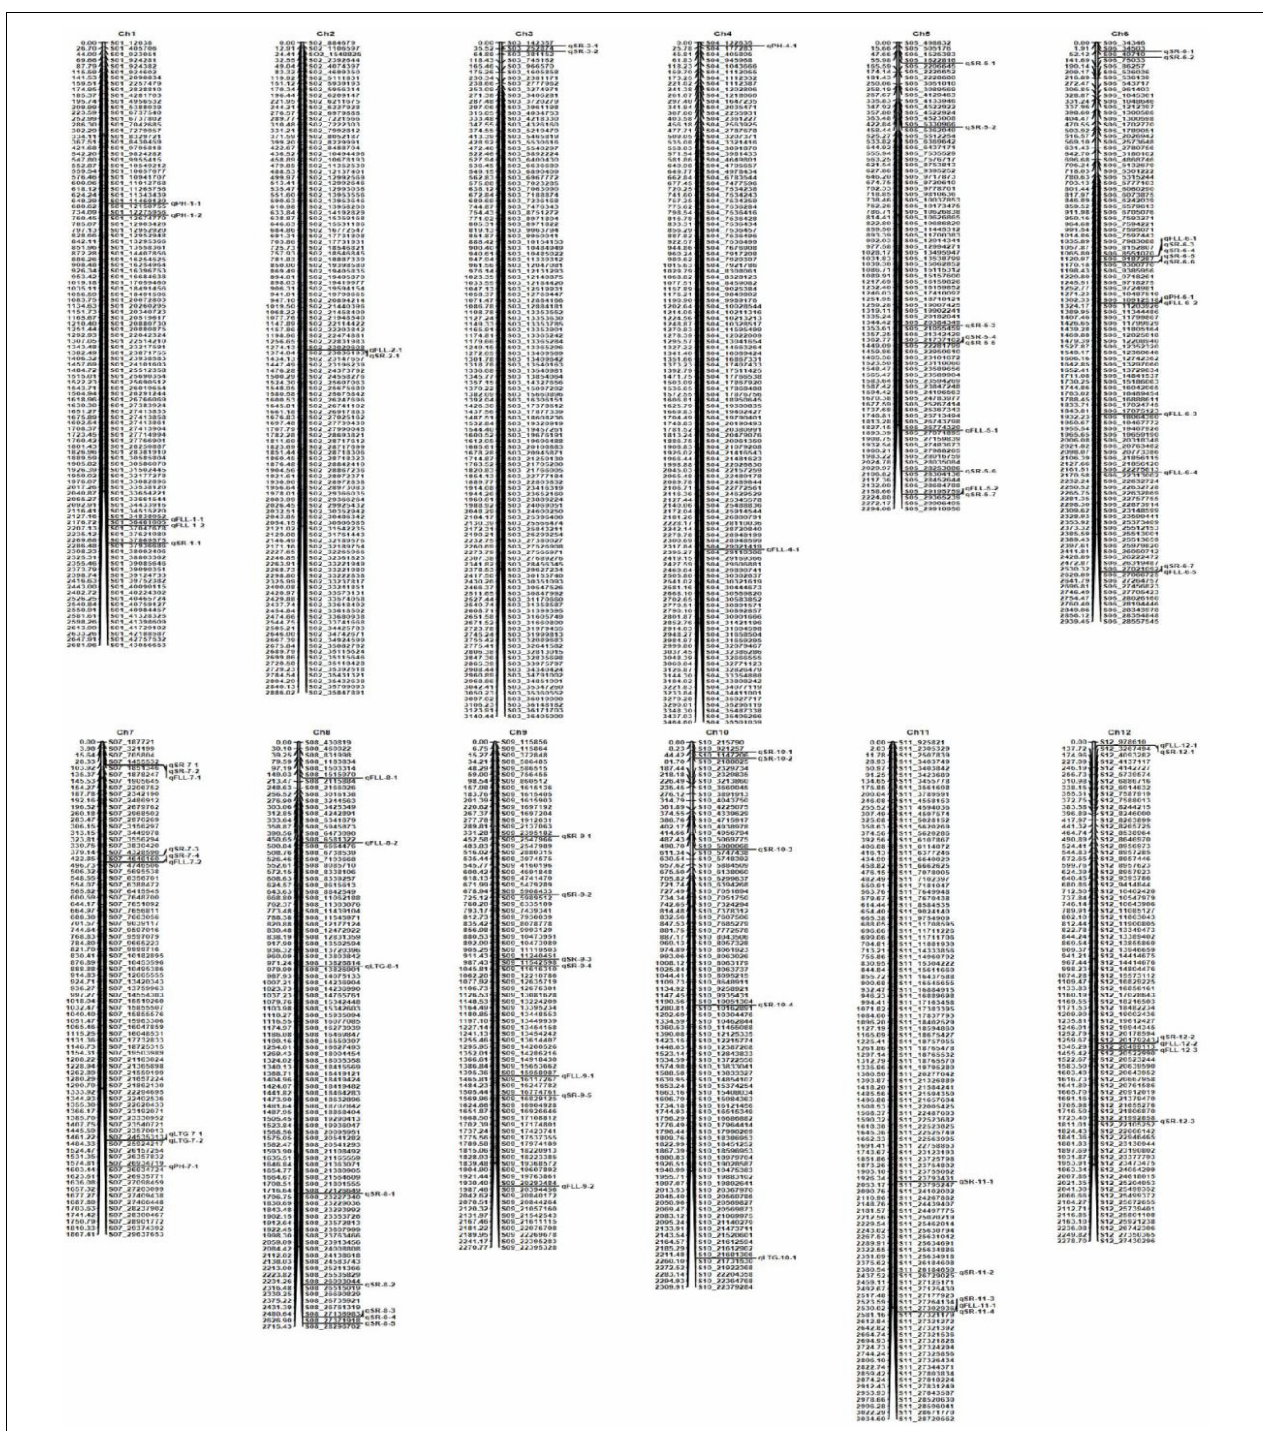
FIGURE 4 | Molecular genetic map showing the positions of QTLs for four traits investigated under cold stress and BR-combined cold treatment.